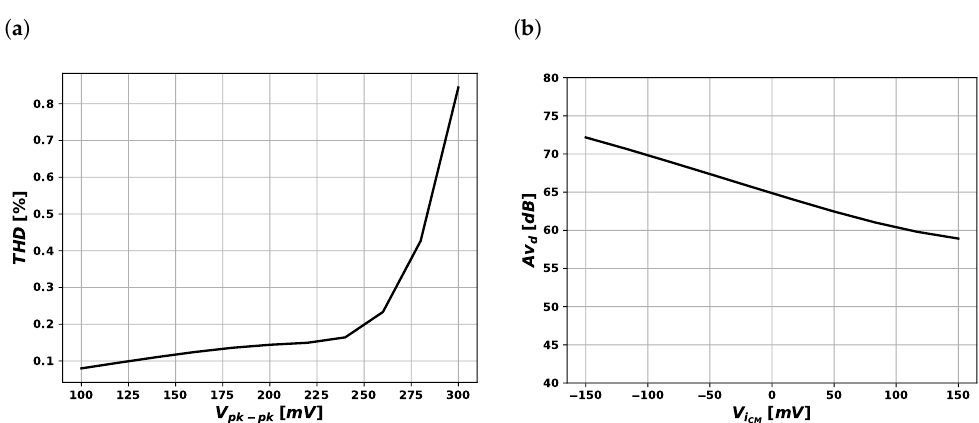
Figure 9. Total harmonic distortion (THD) vs. input signal amplitude ( a ) and differential gain vs. input common mode voltage ( b ).